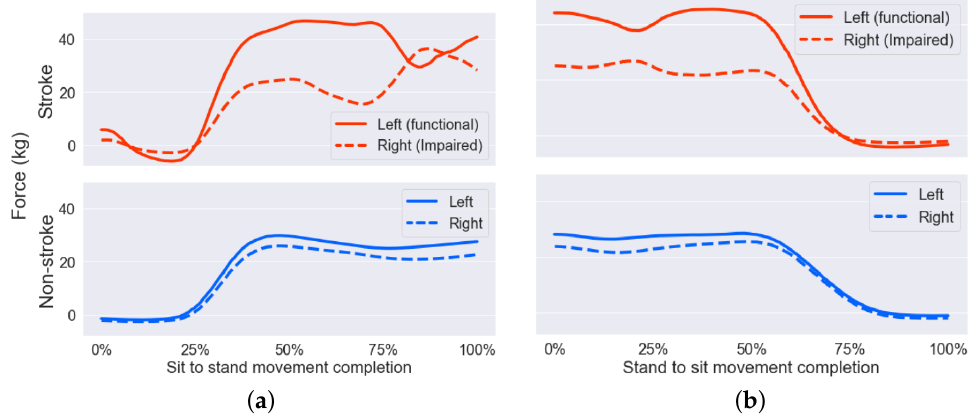
Figure 4. ( a ) Average weight placed on each side of the balance board for stroke ( top ) and non-stroke ( bottom ) users, 10 sit-to-stand movements, at 100% seat height. ( b ) Weight placed on each side of the balance board for stroke ( top ) and non-stroke ( bottom ) users, stand-to-sit movement, at 100% seat